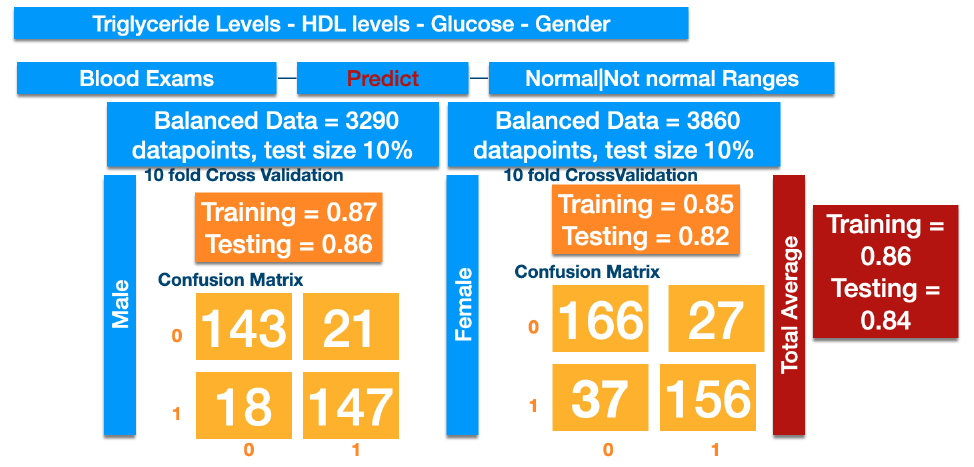
Figure 16. MetS classifier—